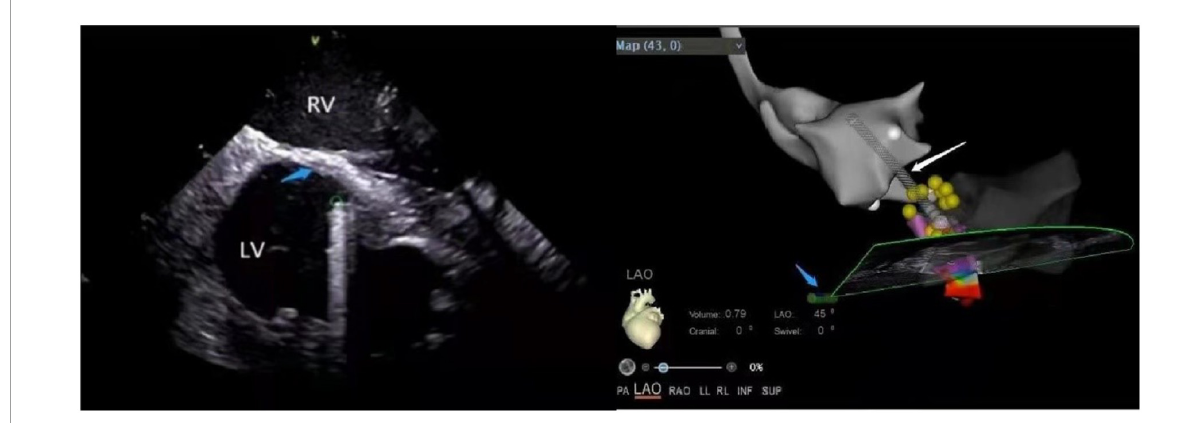
FIGURE10 (Left panel) The ventricular septal scar under ICE. LV, left ventricular; RV, right ventricular; Green circle, the position of the ablation catheter tip; Blue arrow, scar (increased echo density). (Right panel) The position of the ablation catheter tip under the CARTOSOUND module in the ablation of the scar. Left ventricular outflow tract (gray); Conduction beam (yellow balls); White arrow, ablation catheter; Blue arrow, ICE catheter.